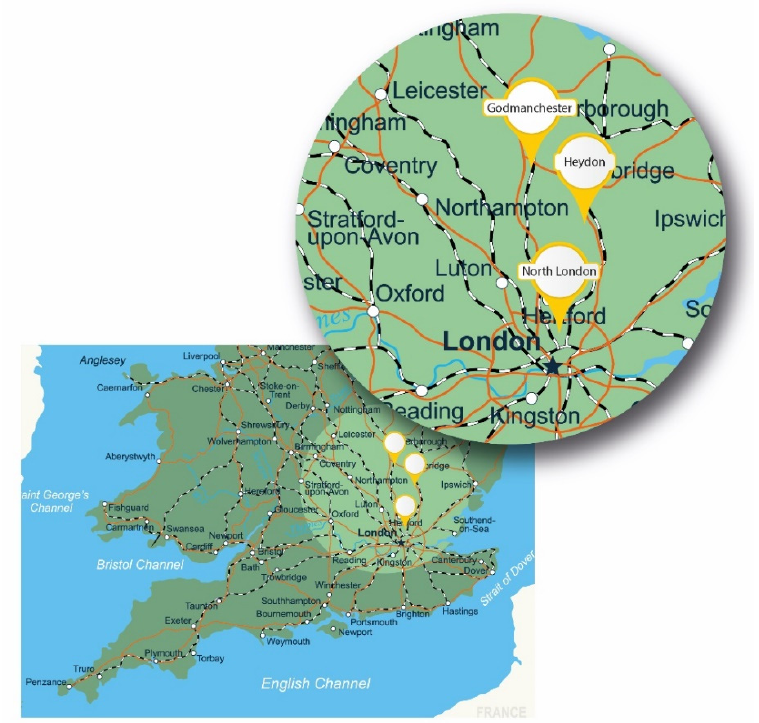
Figure 1. The three locations of Wood Green, The Animals Charity rehoming centres in the UK at the time of sampling. From North to South–Godmanchester, Heydon and North London (now closed) .